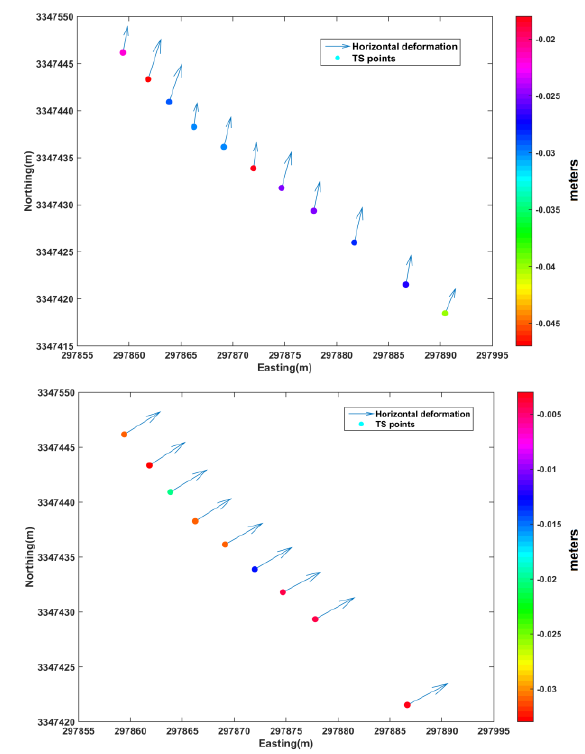
Figure 5. Displacement of target reflectors installed on the retaining wall during epochs 1-2 and 1-3.